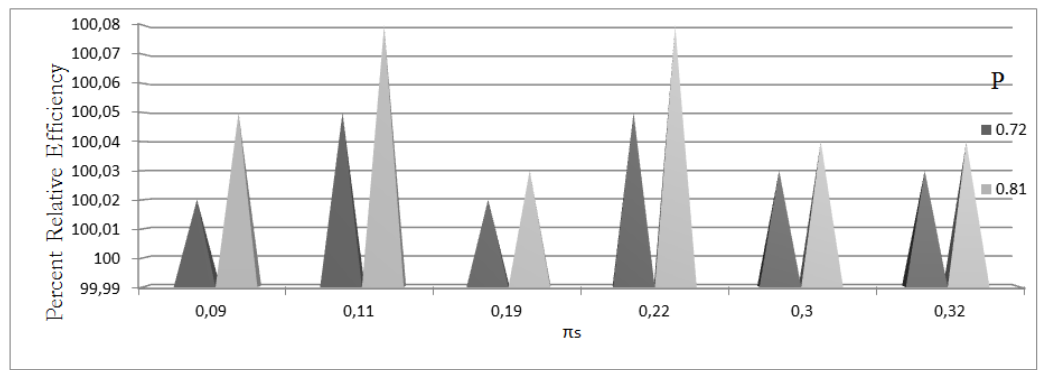
ˆ π under optimum allocation with respect to ST